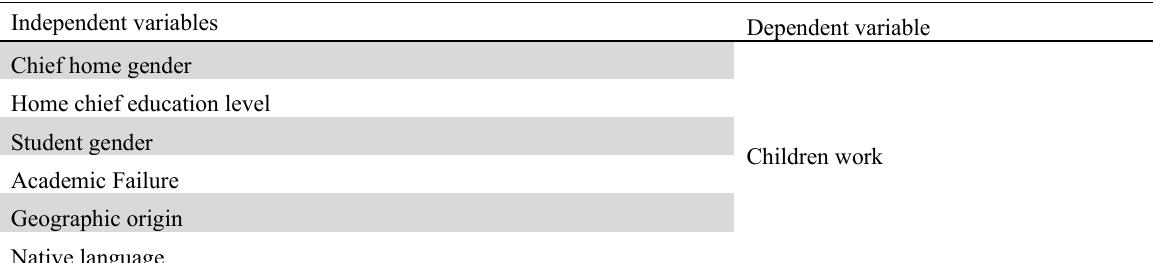
Initial variables Independent